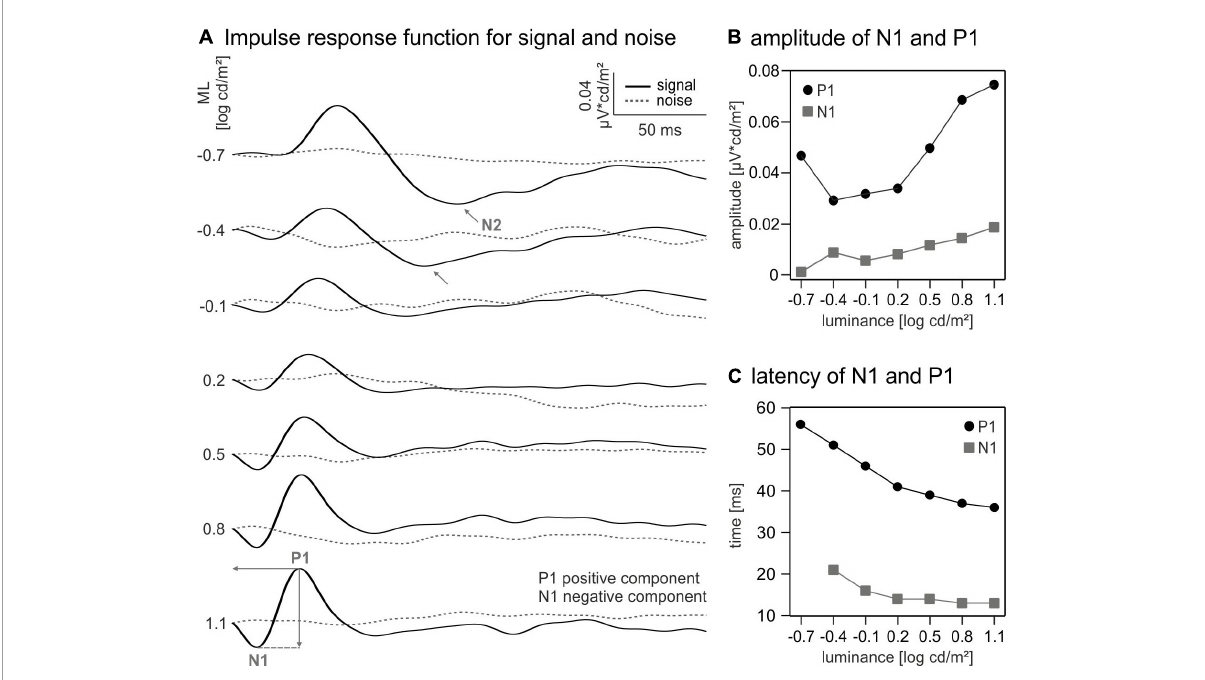
FIGURE2 Impulse response functions (IRFs) and curve components. (A) IRFs for different mean luminances (MLs) calculated using white noise electroretinogram (wnERG) signals (black) and noise measurements (dotted line). Indicated wave components: N1 for first negative trough, P1 for first positive peak, and N2 for second negative trough. (B) Amplitudes and (C) latencies of P1 (black dots) and N1 (grey